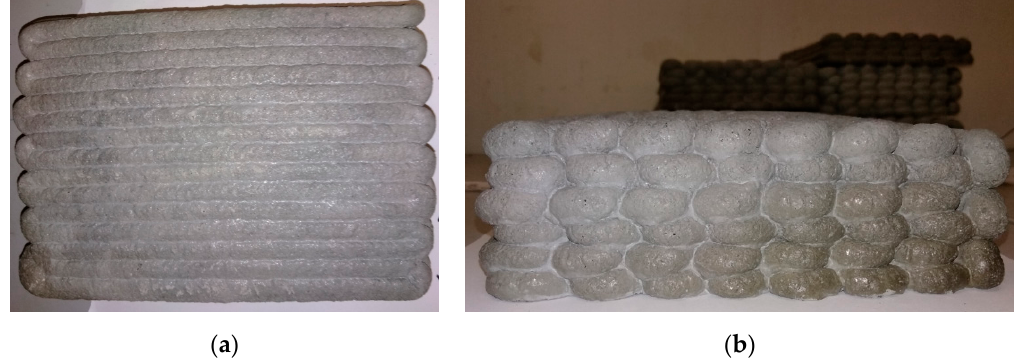
Figure 9. Top-view ( a ) and front-view ( b ) of a printed slab (SSM mix) .